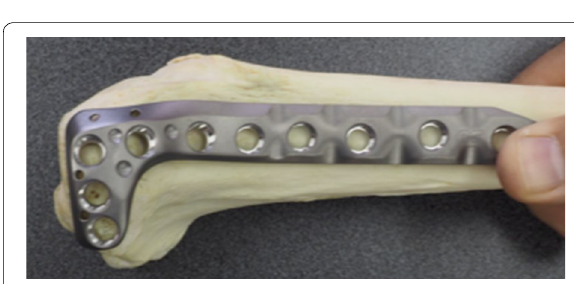
Fig. 2 Lateral view of locking plate placed against cadaveric tibia (Zimmer NCB proximal tibia system)